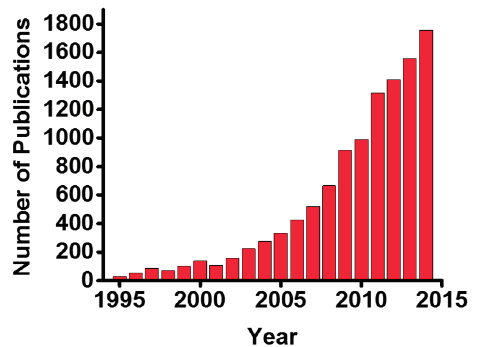
Figure 1. The annual trends in the number of publications of aptamers-related research. The term “aptamer” has been utilized for literature search on Thomson Reuters Web of